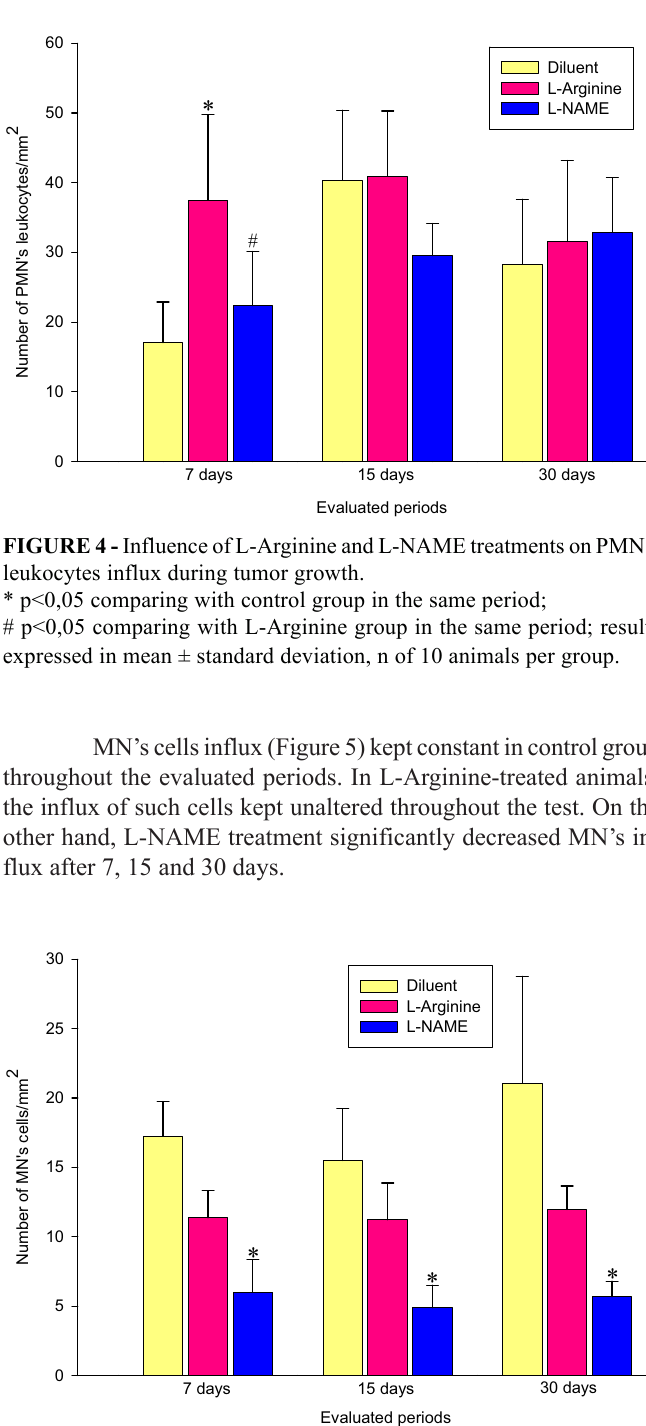
FIGURE 5 - Influence of L-Arginine and L-NAME treatments on MN’s cells influx during tumor